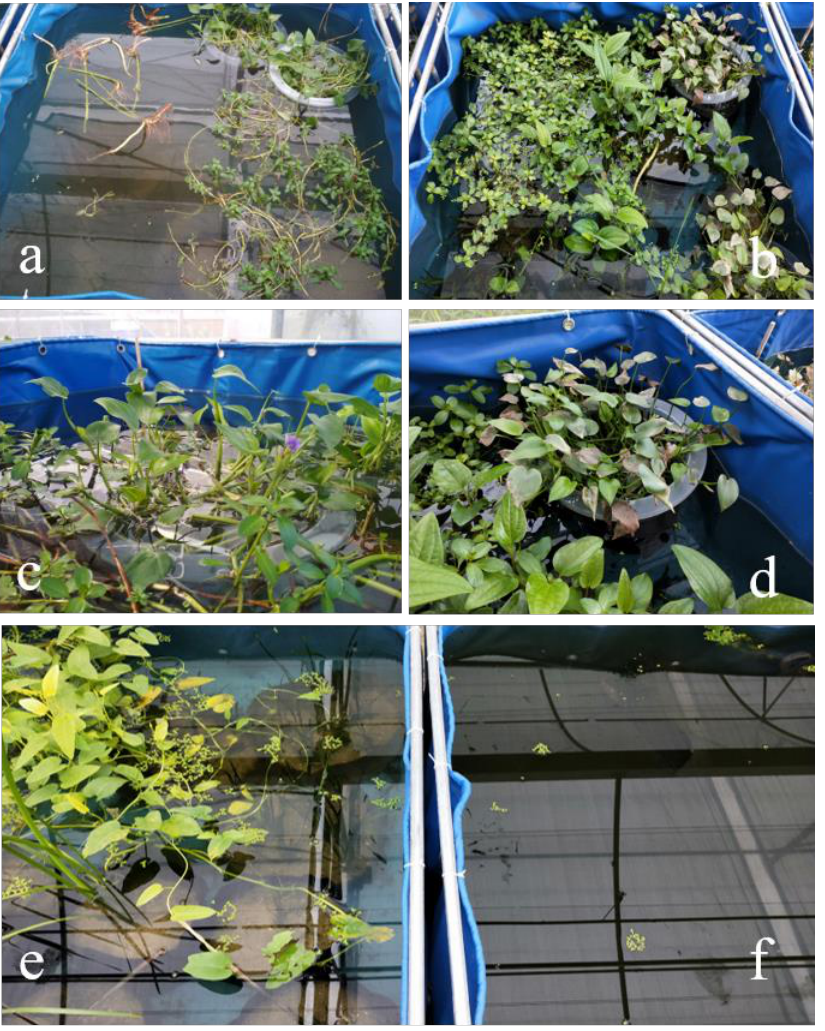
Figure 5. Growth status of plant combinations in wastewater: ( a ) day 0 and ( b ) day 27 of group A; ( c ) day 8 and ( d ) day 27 of M. vaginalis ; ( e ) day 35 of group B; ( f ) day 35 of the CK group. Table 2. Biomasses of aquatic macrophytes after 54 days of treatment in artificial wastewater (g/pot, fresh weight). Plants